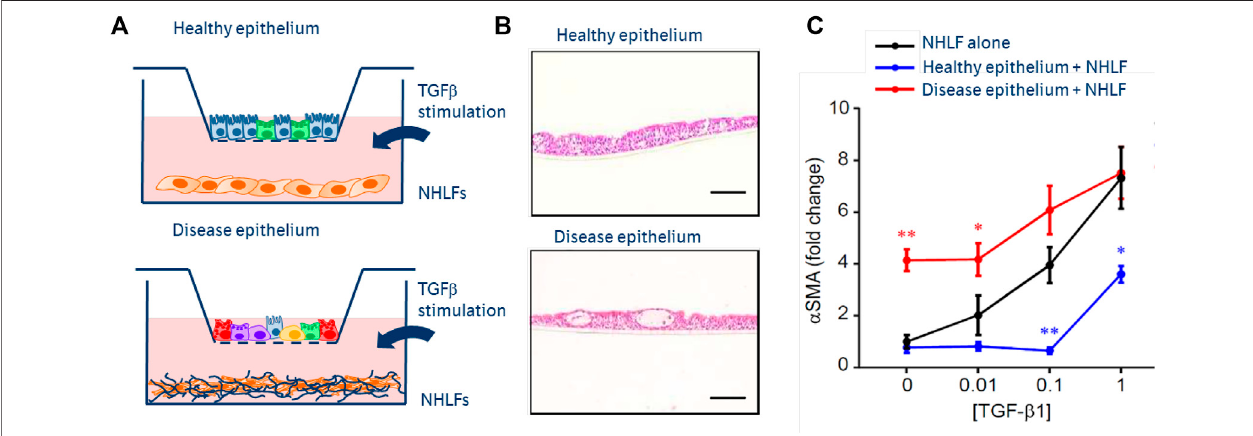
FIGURE 2 | Next generation co-culture assays of epithelial: fi broblast crosstalk. (A) Schematics of epithelial cells, cultured in inserts at air-liquid interface from primary basal epithelium isolated from healthy or fi brosis patient lungs. Normal healthy lung fi broblasts (NHLFs) co-cultured in the below wells — stimulated with increasing concentrations of TGFß. (B) H&E images of healthy vs diseased ( fi brotic) epithelium, showing fewer ciliated cells and more secretory populations. (C) Mono- culture NHLF response to TGFß dose response (black), showing increased a-smooth muscle actin — an indicator of fi broblast to myo fi broblast transition. Fibrotic epithelium promotes fi broblast transition in the absence of TGFß (red). Healthy epithelial co-culture protects fi broblasts from pro- fi brotic effects of TGFß.